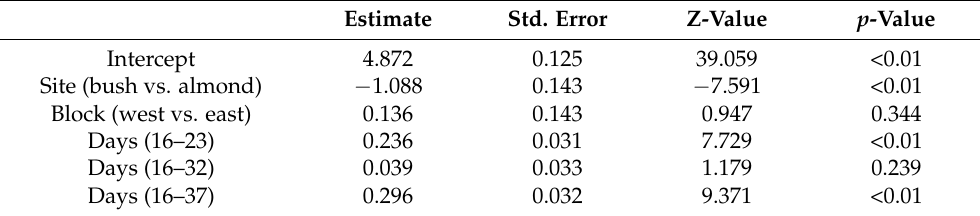
Table 2. Estimated regression parameters, standard errors, z-values, and p -values for the Poisson generalized linear mixed model conducted to compare bee activity by site and days after placement. The estimated variance for the random effect ‘hive’ is